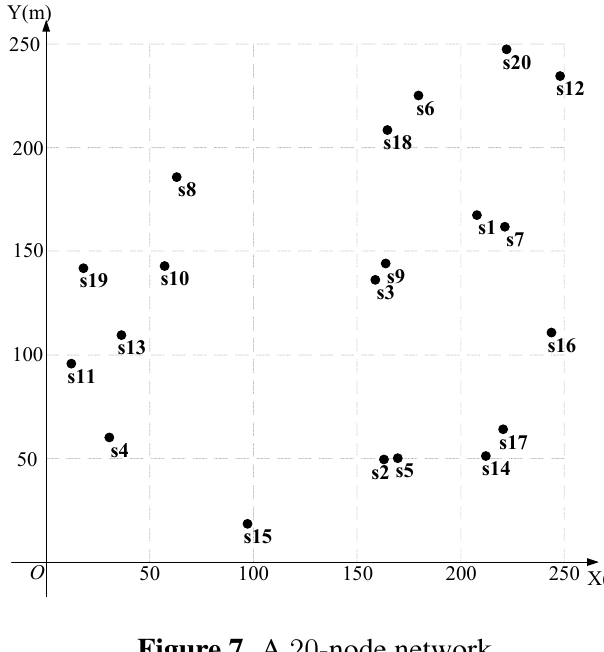
Figure 7. A 20 -node